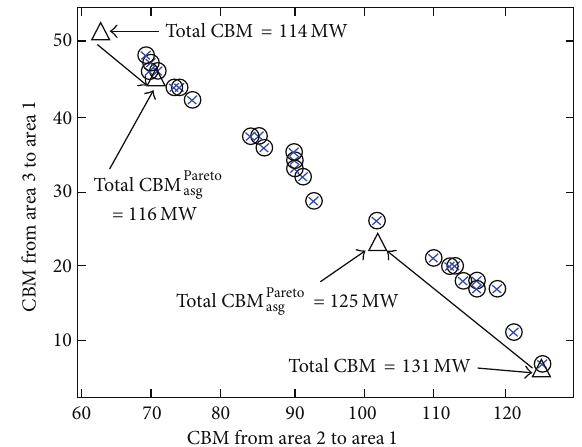
Figure 8: Total CBM Pareto selection based on the ranking index in asg Pareto optimal front